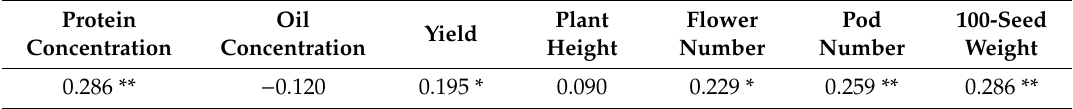
Table 9. Correlation coe ffi cient of yield and yield components traits with fertilization treatments. Plant Protein Oil Yield Concentration Concentration